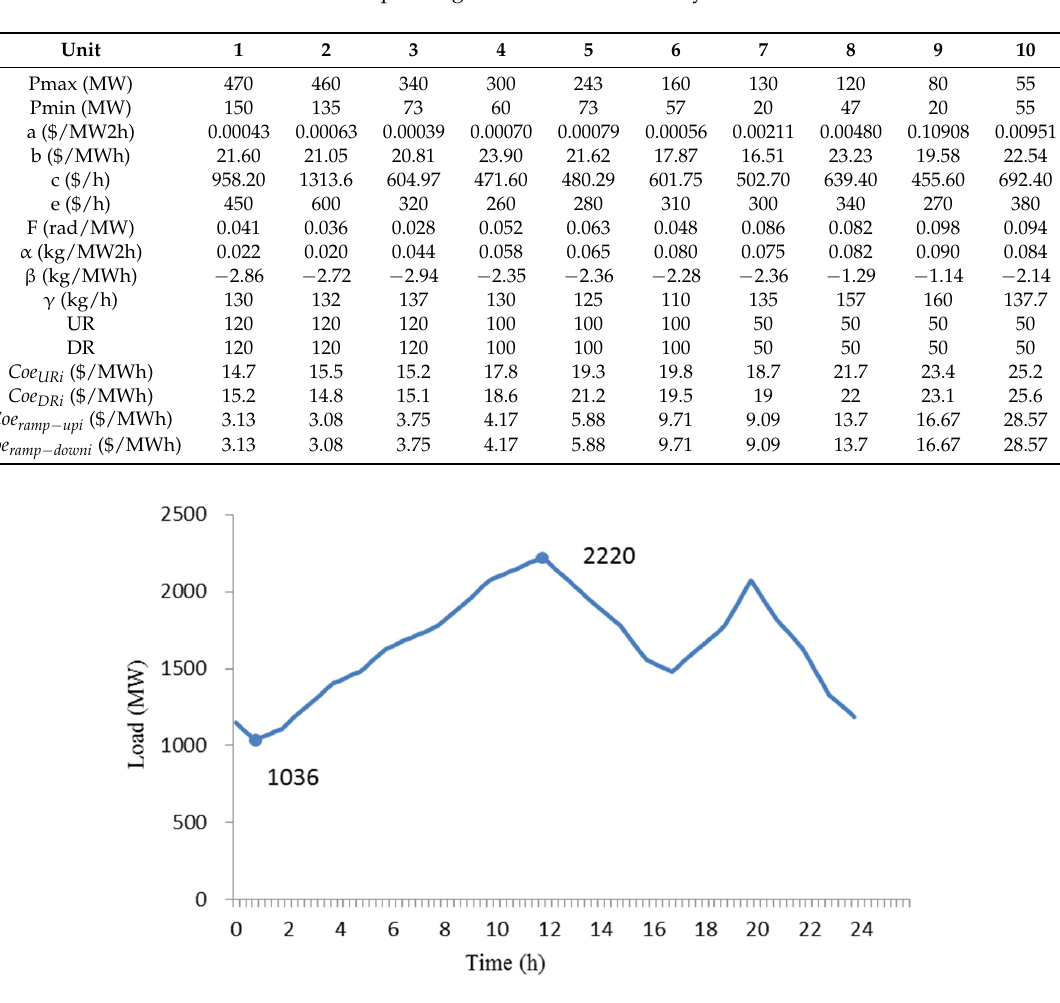
Table 1. Installed capacity of wind farms and SLBFLs.